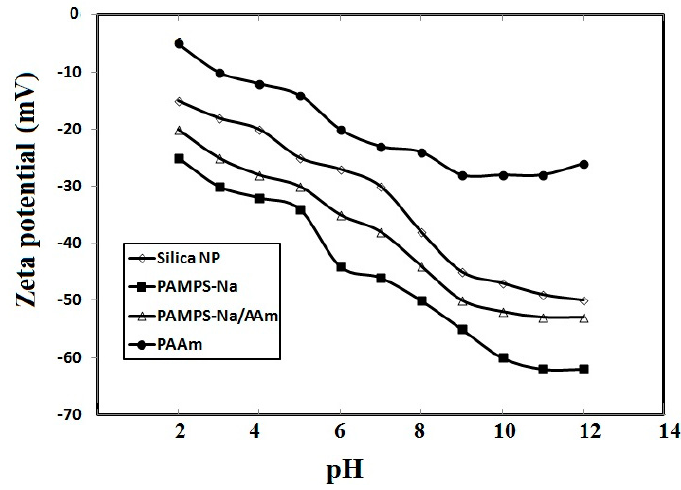
Figure 3. Zeta-potential data of silica-nanogel composites at different pH aqueous solutions.